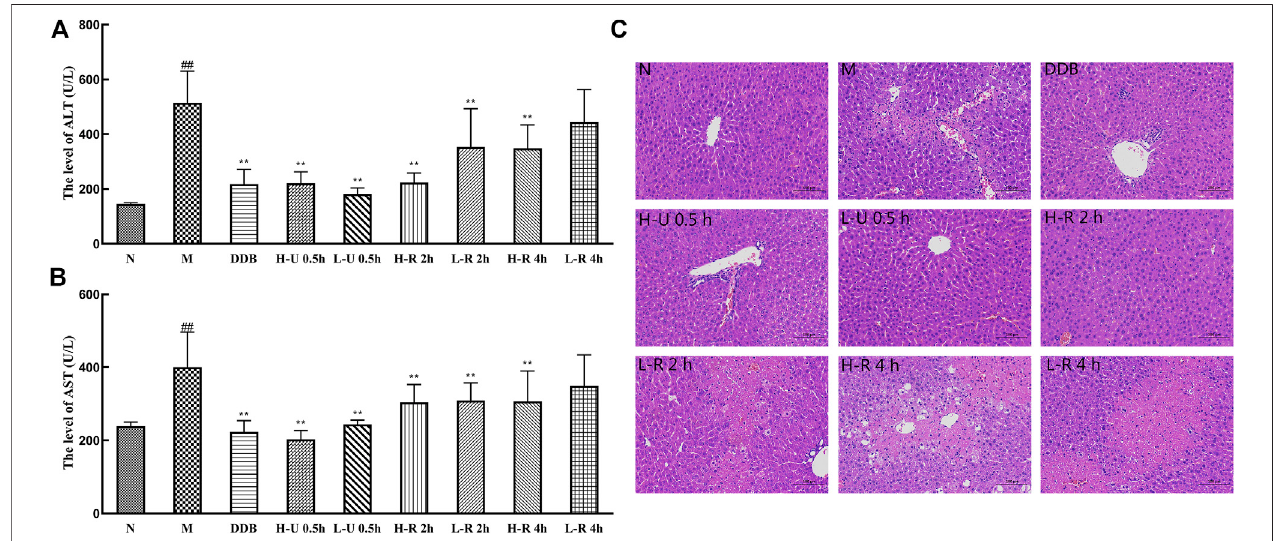
FIGURE 4 | Comparison of serum levels of ALT (A) and AST (B) ( x ± s, n (cid:1) 6). Compared with group N, # p < 0.05, ## p < 0.01; compared with group M, * p < 0.05, ** p < 0.01. Hepatic tissue sections under microscope (C) (H&E Stain, × 200).